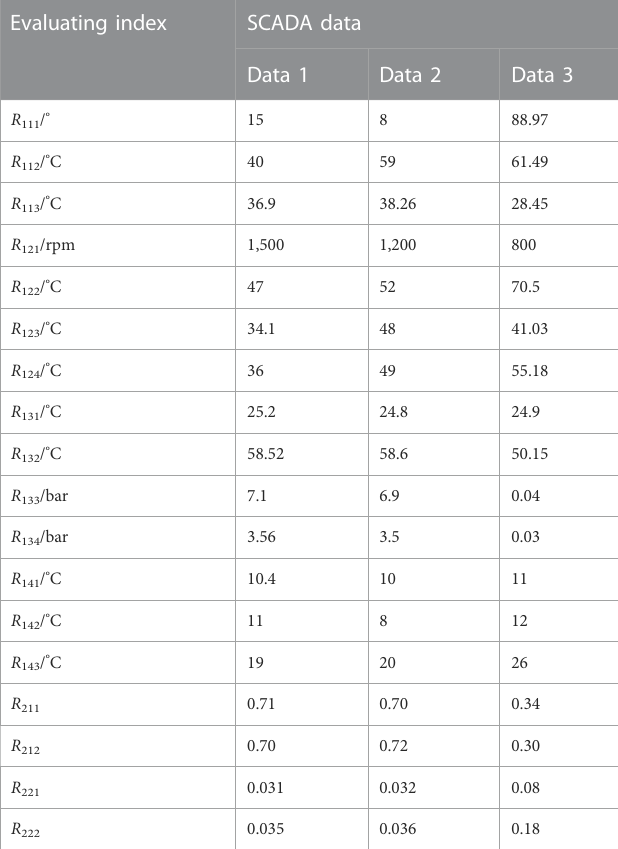
TABLE 5 SCADA data of a 1.5 MW wind turbine.